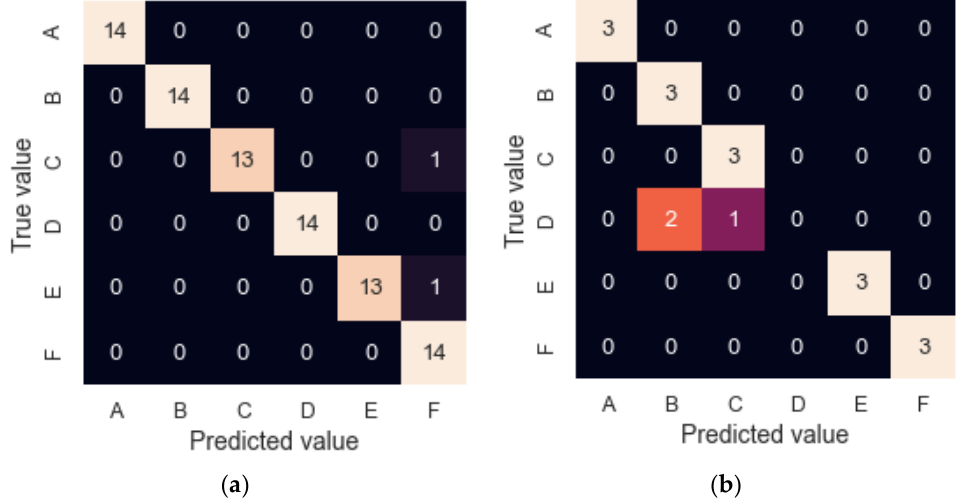
a ± 10% error margin of the real concentration.